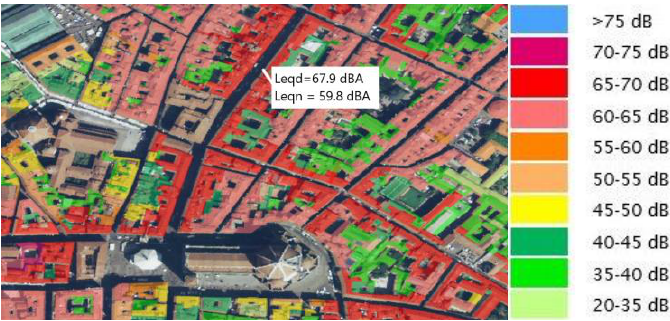
Figure 3. Road traffic noise map of the center of Florence; the colors of the map refer to values of L den , while values in the box refer to the SPL in the facade of the buildings, expressed with the Italian indicators for day-time and night-time (L Aeqd, 6 – 22 h and L Aeqn, 22 – 6 h , respectively).